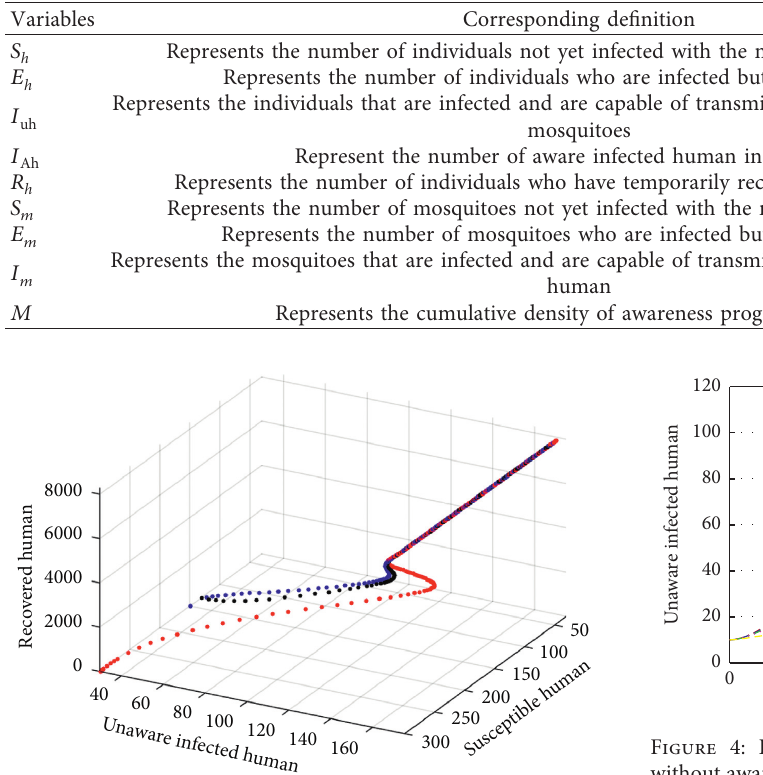
Figure 2: Convergence of solutions with different initial conditions.